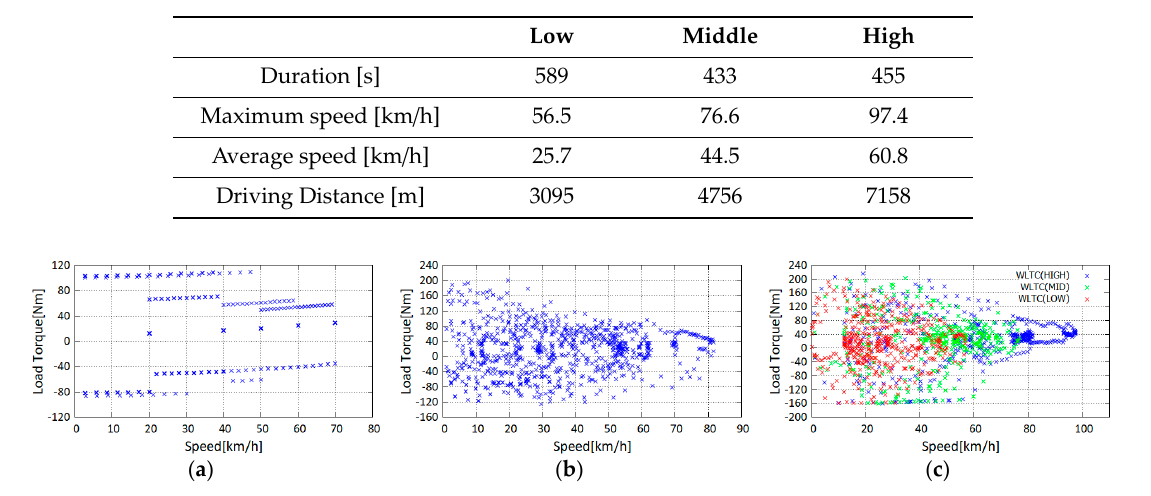
Figure 7. Torque–speed maps of the driving cycles: ( a ) 10–15 mode; ( b ) JC08 mode; ( c ) WLTC mode. Table 2. Specifications of 10–15 mode and JC08 mode.